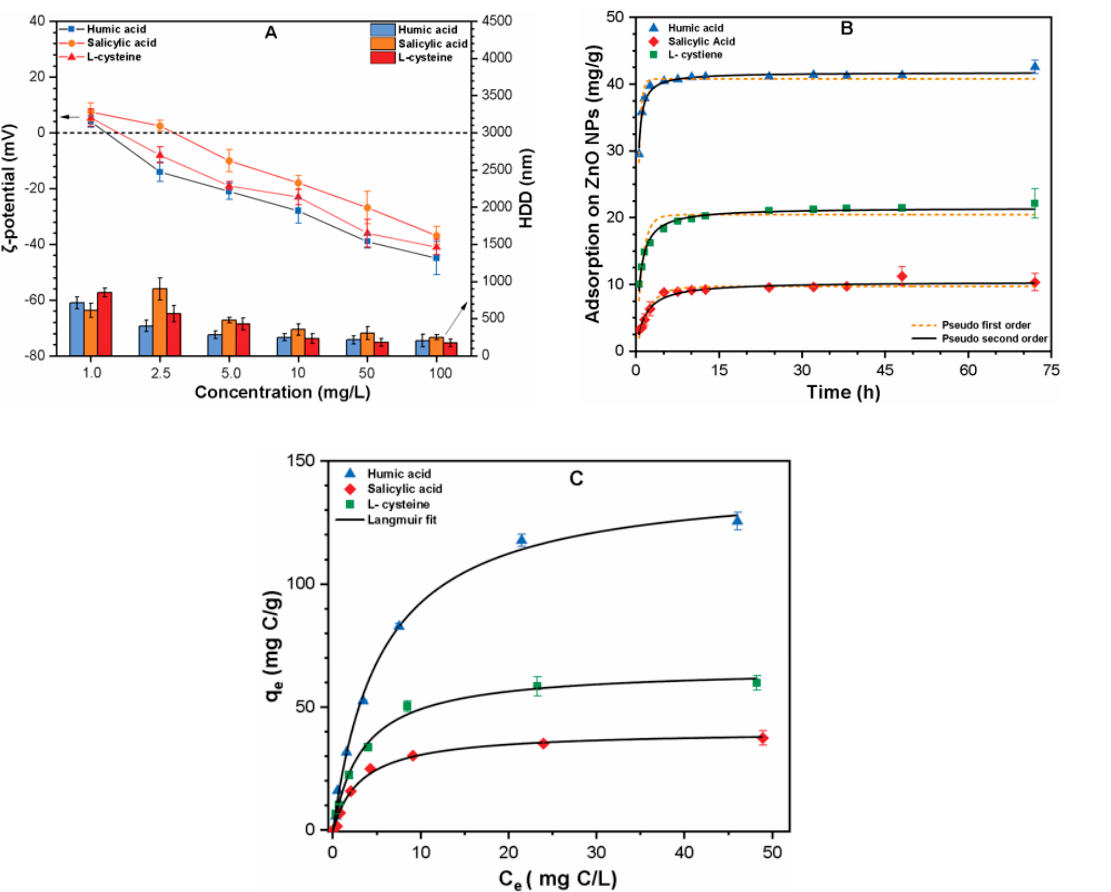
Figure 2. ( A ) The ζ -potential and HDD profile of ZnO NPs (30 mg/L) suspension at different concentration (1–100 mg/L) of organic ligands; ( B ) adsorption kinetics (10 mg/L of each organic ligand); ( C ) adsorption study (50 mg C/L of each organic ligand) at pH 7. The values are the mean of n = 3 (mean ± standard deviation).